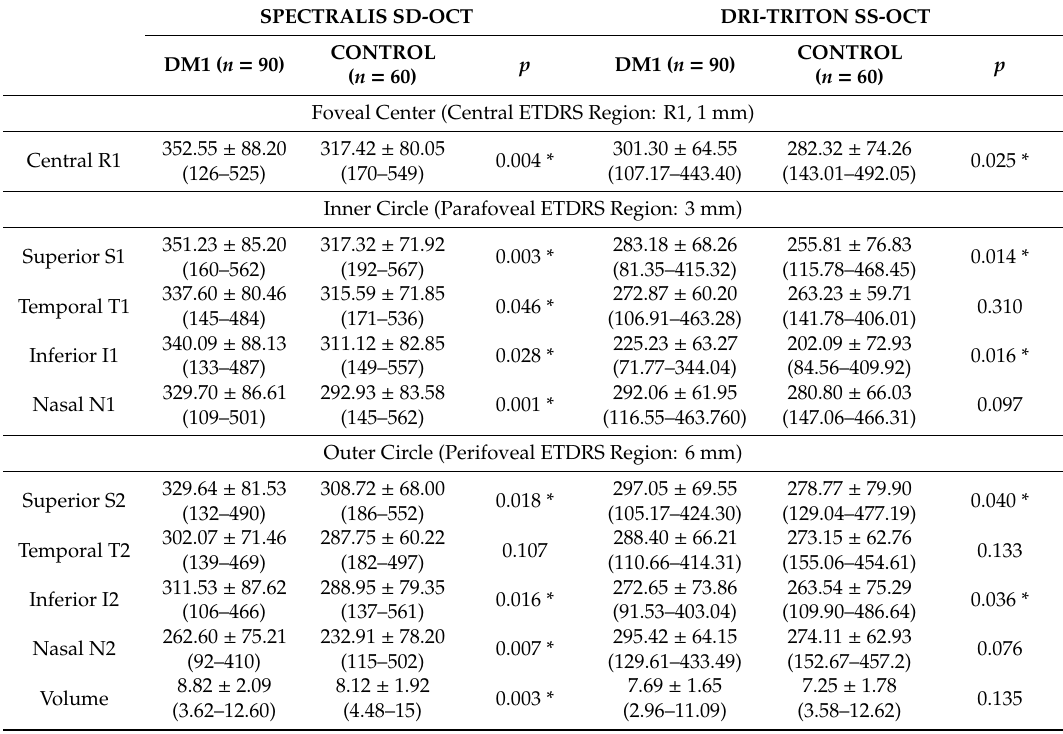
Table 2. Choroidal thicknesses in the ETDRS quadrants expressed in µ m (from the Bruch’s Membrane (BM) to the choroid-scleral limit) measured with the Spectralis spectral domain optical coherence tomography (SD-OCT) and the deep range imaging (DRI)-Triton swept source optical coherence tomography (SS-OCT) in the type 1 diabetes Mellitus (DM1) group and the control group. Values are presented as the mean ± standard deviation and range (minimum-maximum). Significant di ff erences were considered as p < 0.05, calculated by Kolmogorov–Smirnov test for two independent nonparametric samples, are shown with *. The volume is represented in mm 3